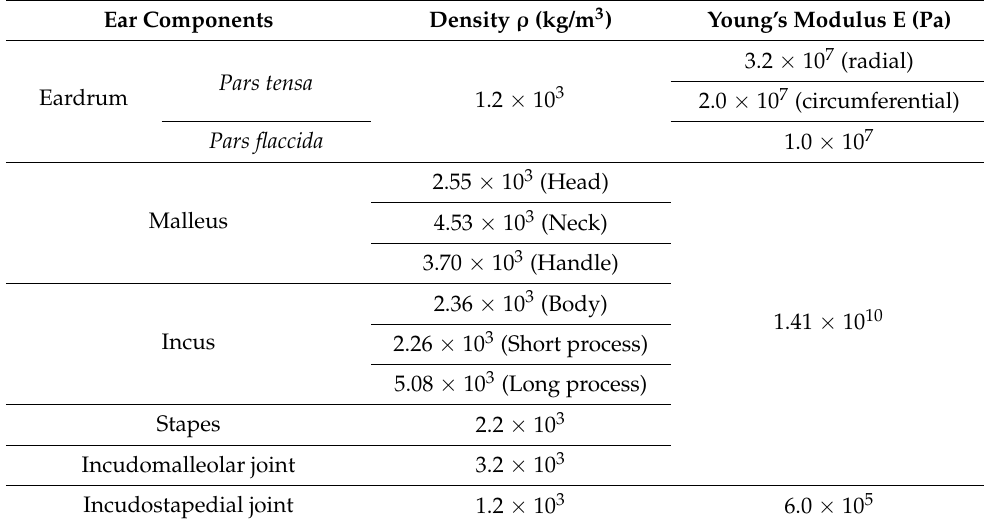
Table 1. Material properties of the eardrum, ossicles and joints [20,21].